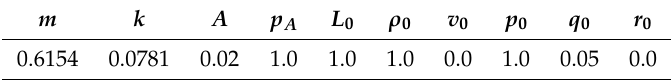
Table 1. Parameters and initial conditions for piston